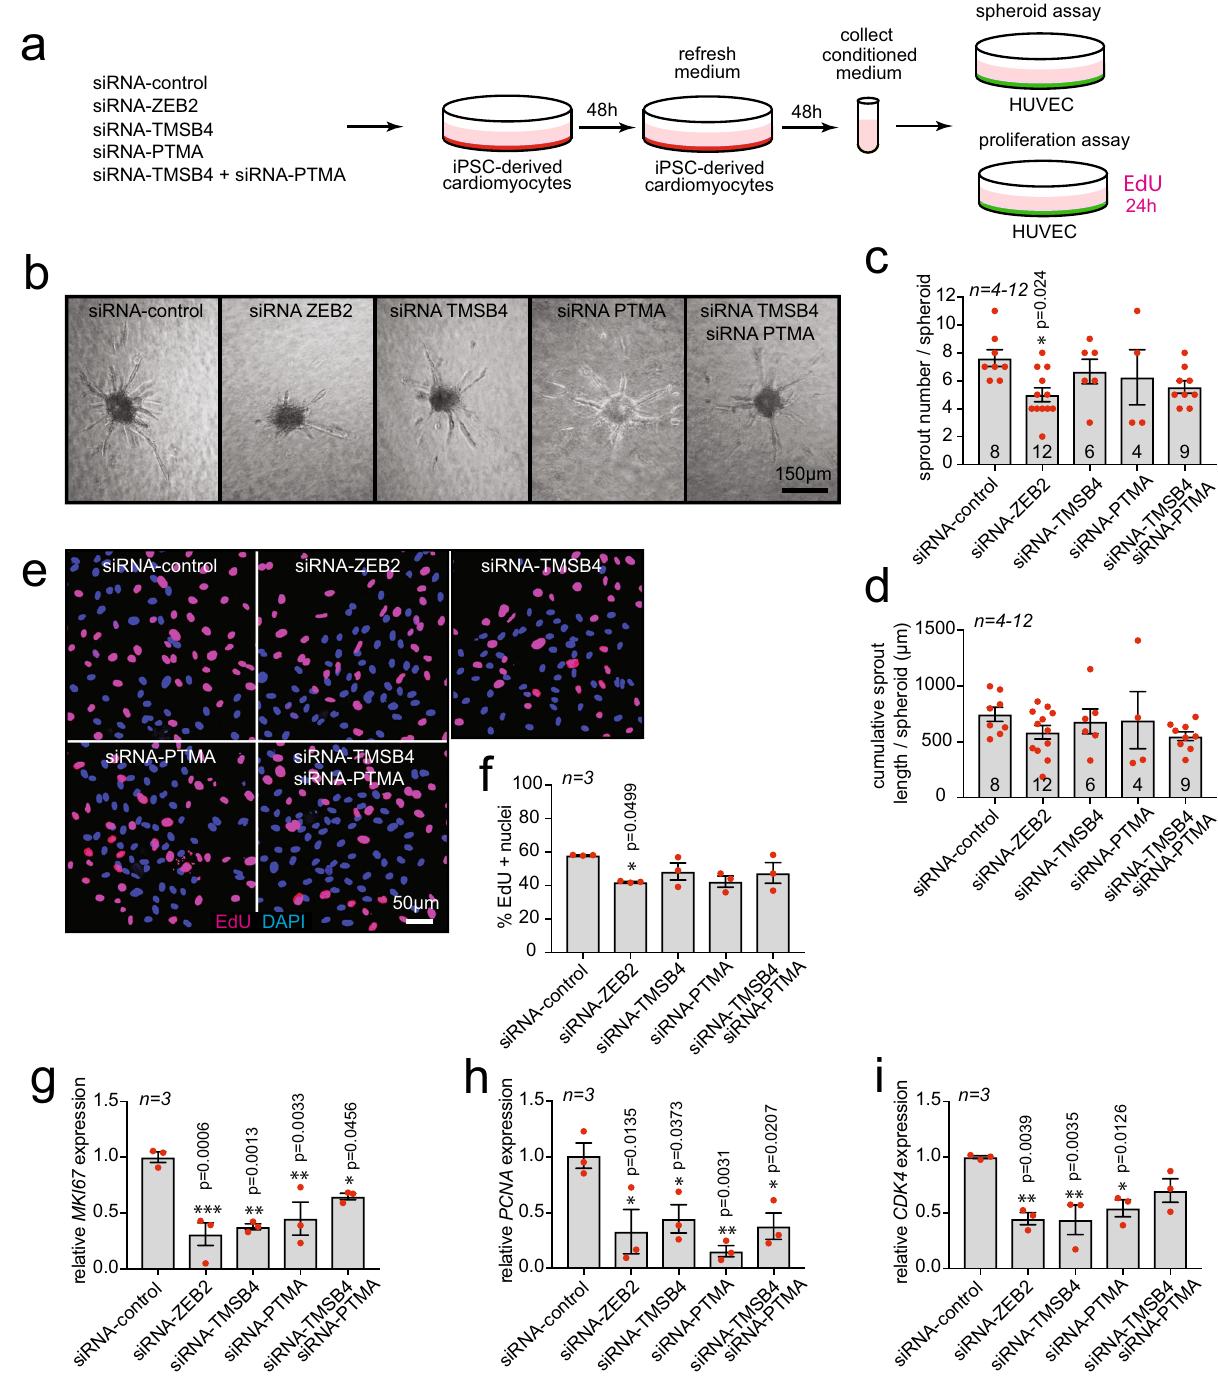
Fig. 5 Knock-down of ZEB2, TMSB4, and PTMA in cardiomyocytes inhibits endothelial cell migration and proliferation. a Experimental setup. b Representative images of sprouts formed by HUVECs upon treatment indicated in ( a ). c Quanti fi cation of sprouts number per spheroid. d Quanti fi cation of cumulative sprout length per spheroid. Data in b - d is from one experiment with 4-12 biological replicates. e Representative immuno fl uorescent images of HUVECs treated as indicated in ( a ), nuclei stained for DAPI and EdU. f Quanti fi cation of EdU positive nuclei. g - i mRNA expression levels of g Mki67 , h Pcna i Cdk4 in HUVECs treated with conditioned medium from ( a ). Data are represented as mean ± SEM, each dot indicates a biological replicate, n is indicated in fi gures. Data were analyzed by ordinary one-way ANOVA with Dunnett ’ s multiple comparison test ( c , d , f , g , h , i ). Source data are provided as a Source Data fi